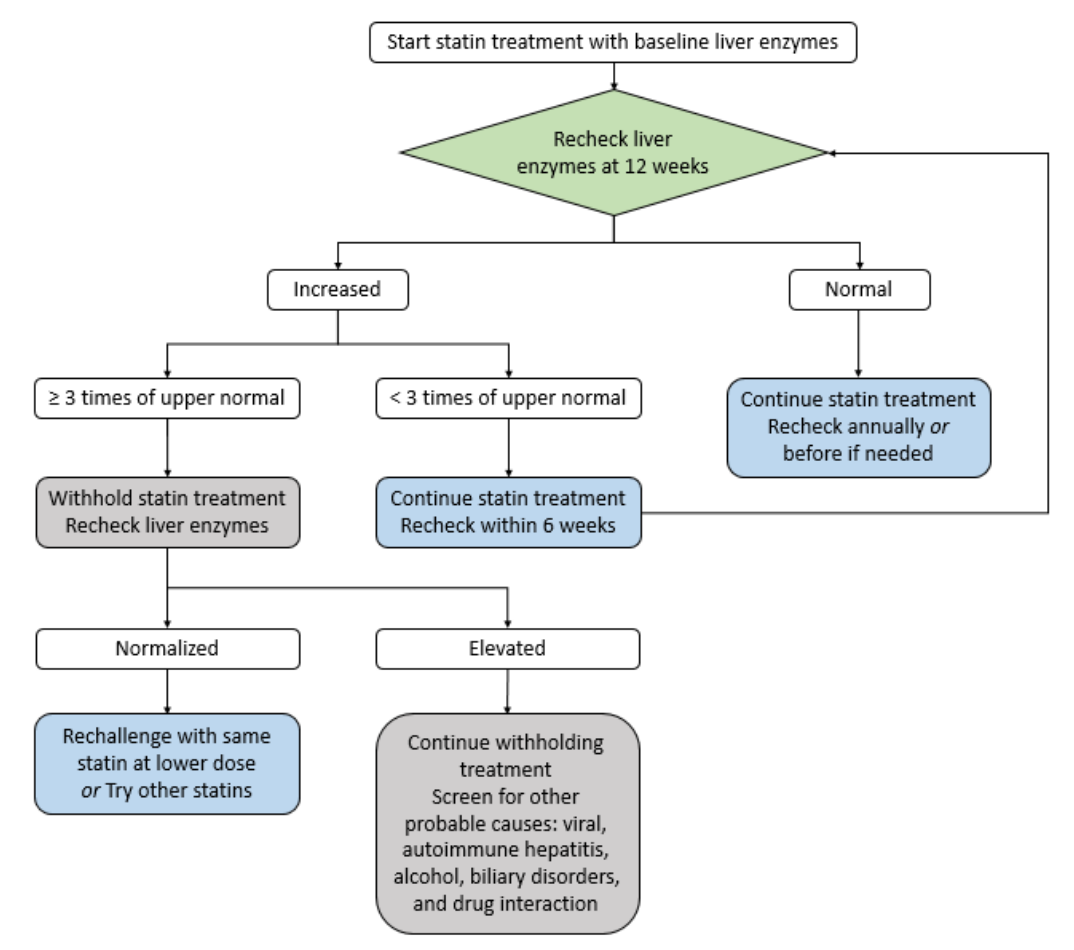
Figure 4. The strategy of statin treatment for liver toxicity [56].